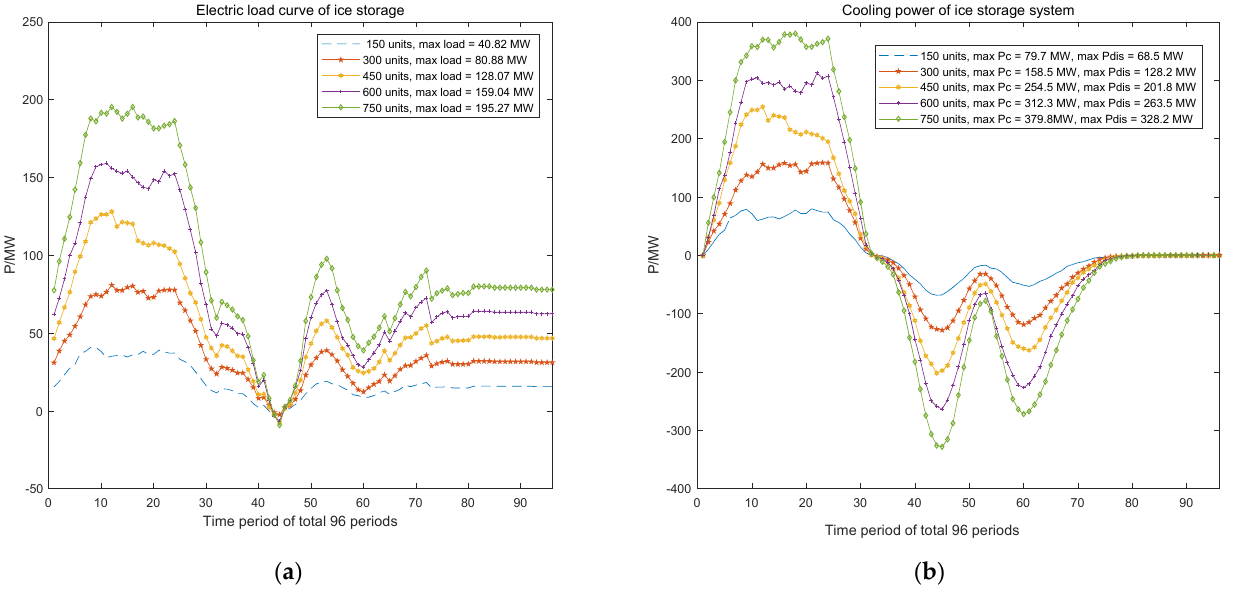
Figure 5. An ice storage system: ( a ) electric load curve of ice storage system; ( b ) cooling power of an ice storage system.